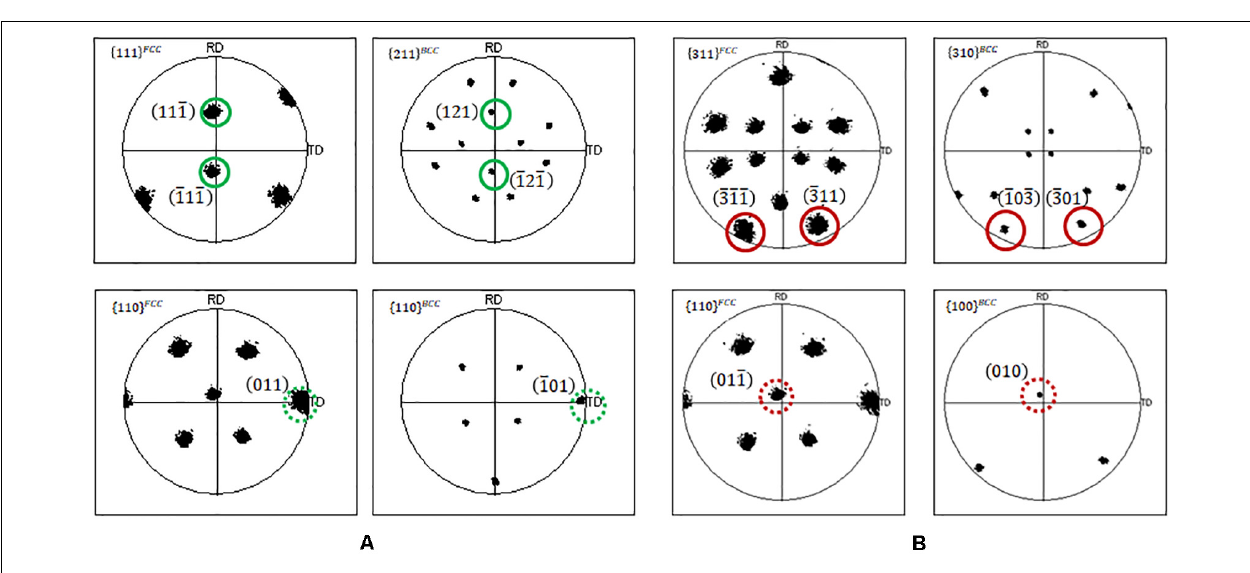
FIGURE 4 | Selected pole figures for grain 1, see Figure 3A , illustrating the primary (A) and the secondary (B) crystallographic orientation relationship between FCC and the parent BCC phase. Full circles mark the superposing poles, which correspond to the common planes. Dotted circles mark the superposing poles, which correspond to the common direction. Common planes and directions are indexed with the corresponding {hkl}-triplets.